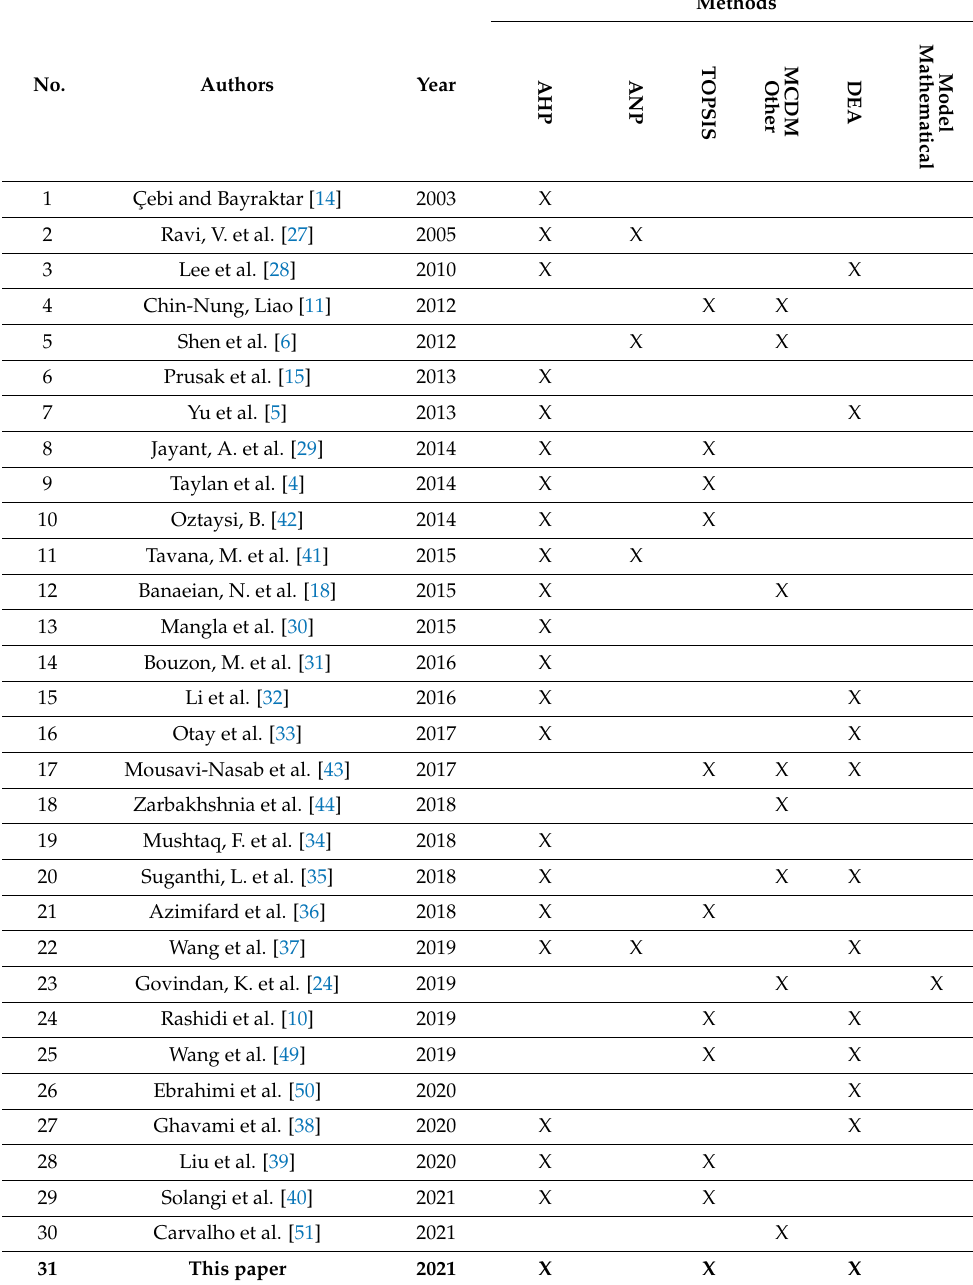
Table 2. Alternative selection MCDM method